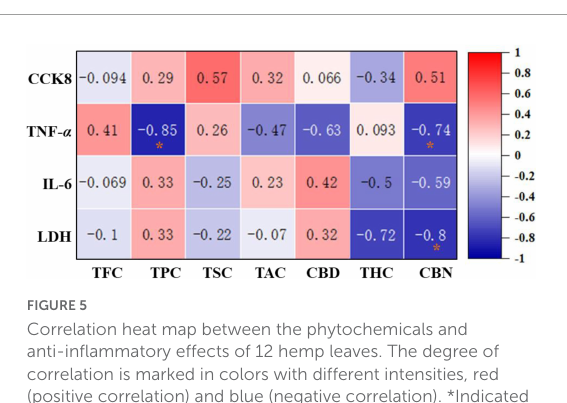
FIGURE4 The levels of pro-inflammatory cytokines secreted MDCK cells treated with hemp leaf extracts and LPS-induced inflammation. Data are expressed as the mean ± SD ( n = 3). The superscript letters (a–l; a–j) indicated statistical significance at p < 0.05.